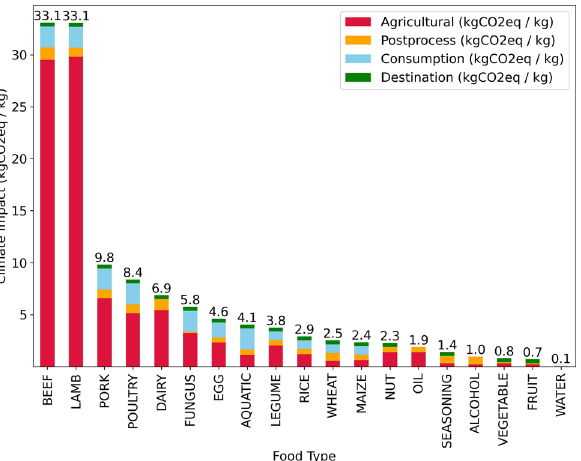
Figure 9. Full life cycle assessment of greenhouse gas emissions for different food types: agricultural, post- process (including post-harvest handling and storage and processing and packaging), consumption, and destination (i.e. waste